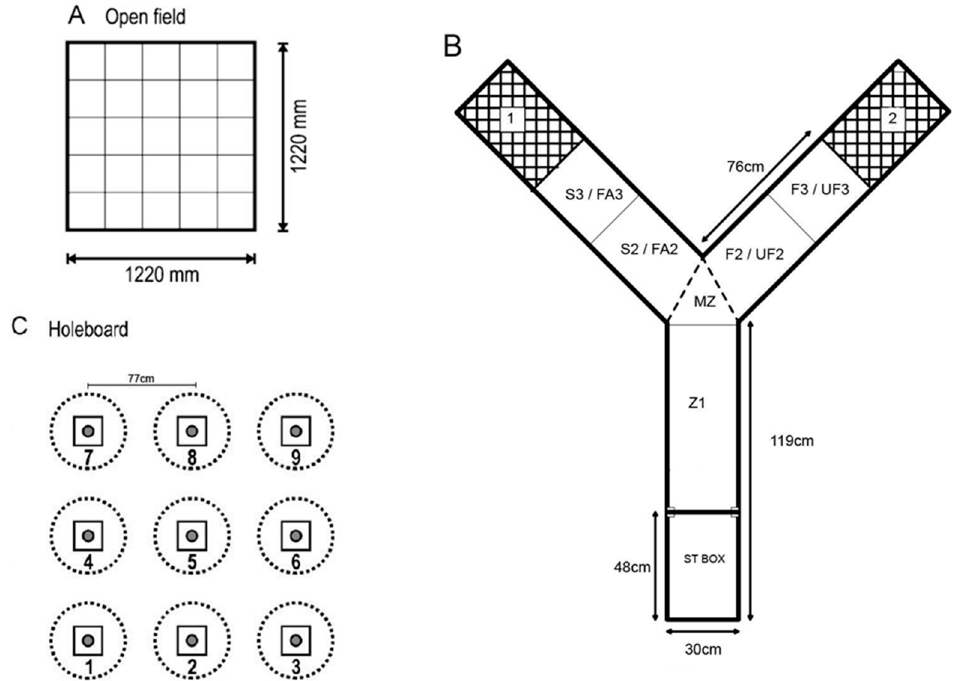
Figure 1. Schematic diagrams of the behavioral apparatus used. ( A ) A birds-eye view of the open field apparatus. All small squares measured 25 cm × 25 cm. A net was draped over the top to prevent escape. ( B ) A birds-eye view of the Y-maze apparatus. For the social versus foraging test, 1 would contain either a pair of pen mates or a foraging zone with scattered feed, and 2 contained the opposite to 1. Each subject chick was randomly assigned 1 = social stimulus or 1 = foraging stimulus. S3 = social zone, S2 = social arm zone, F2 = feeding arm zone, F3 = zone in proximity to feeding zone. For the social recognition test, 1 would contain either a pair of pen mates or a pair of unfamiliar conspecifics from another treatment group, and 2 contained the opposite to 1. Each subject chick was randomly assigned 1 = familiar stimulus or 1 = unfamiliar stimulus. FA3 = familiar zone, FA2 = familiar arm zone, UF2 = unfamiliar arm zone, UF3 = unfamiliar zone. In both tests: MZ = midzone, Z1 = zone 1, ST BOX = start box. ( C ) A birds-eye view of the holeboard apparatus. Circles were drawn with chalk and had a diameter of 50 cm. The distance between each center of the cup (shaded small circles) was 77 cm. The 9 cm × 9 cm squares were medium density fiberboard attached to the cup to keep them steady.